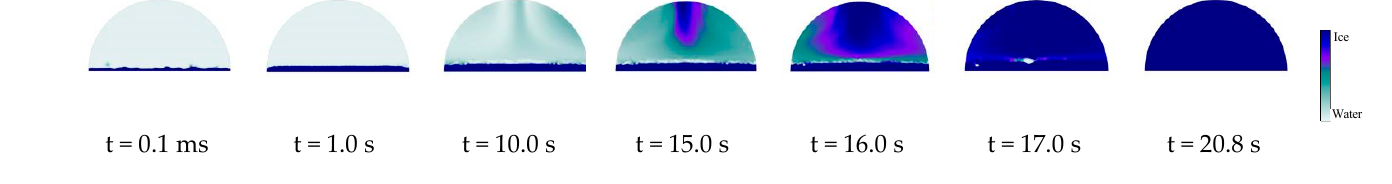
Figure 18. Freezing of the water droplet at 263.15 K.